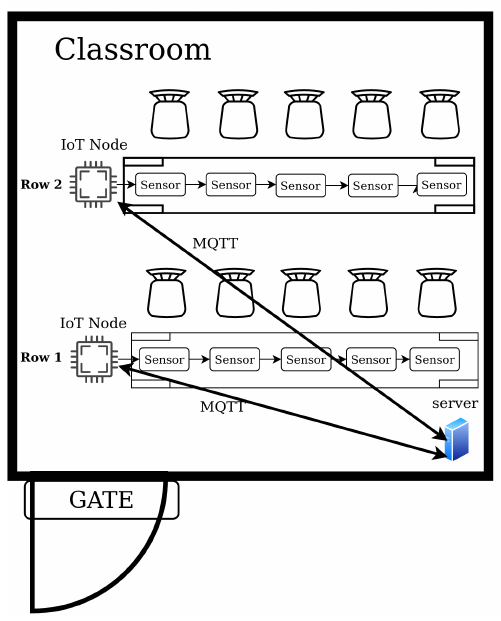
Figure 1. The system concept